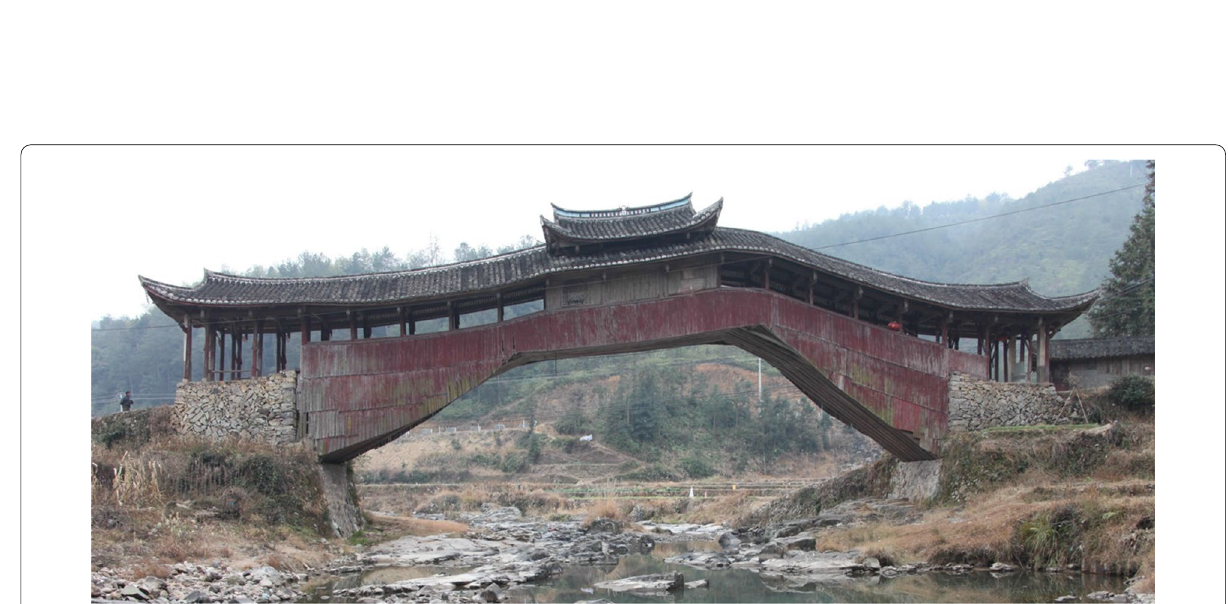
Fig. 6 The Wenxing